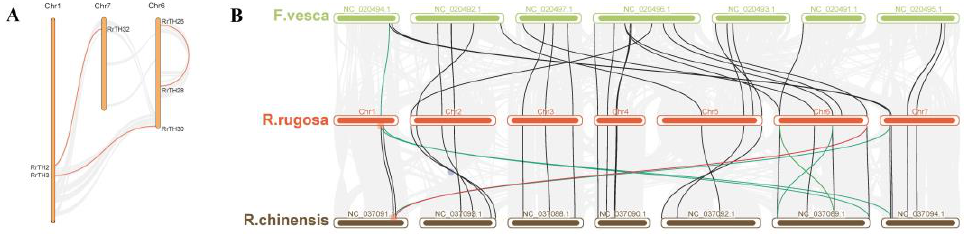
Figure 2. The intra-species ( A ) and inter-species ( B ) synteny of RrGT family. ( A ) The paralogous RrGTs on synteny regions (dark lines) of chromosome 1/6/7. Three RrGT pairs are highlighted (Table S2). ( B ) Synteny regions (dark lines) of genomes of R. rugosa (red), Fragaria vesca (green), R.chinensis (brown) and orthologous GTs (color lines). The orthologous GT pairs are linked by black lines. Green lines indicate GT pairs on overlapped synteny regions.